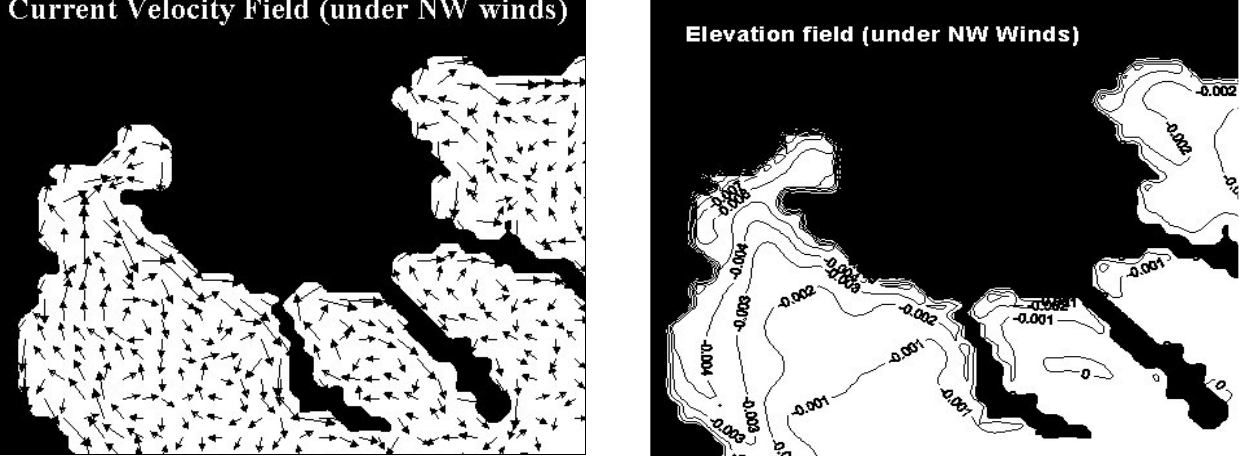
Fig. 7. Surface Elevation field due to northwestern winds (19 September